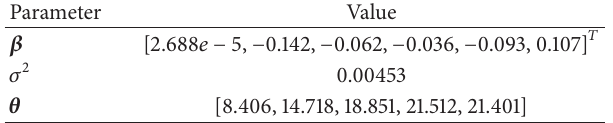
Table 4: The parameters of the Kriging model.